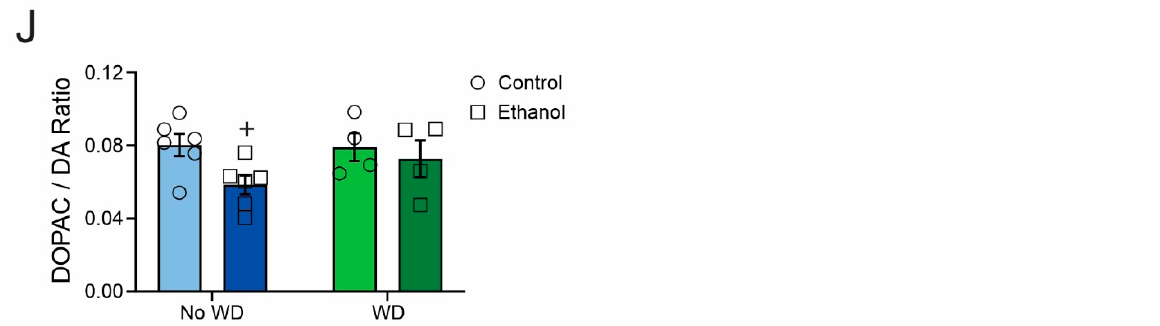
Figure 4. Chronic two-bottle choice ethanol consumption increases D2 dopamine autoreceptor sen- sitivity. One day of ethanol consumption ( A , B ) did not significantly alter D2 dopamine autoreceptor regulation of dopamine release. However, following four weeks of two bottle choice drinking, D2 dopamine autoreceptors were sensitized, resulting in a greater inhibition of dopamine release upon